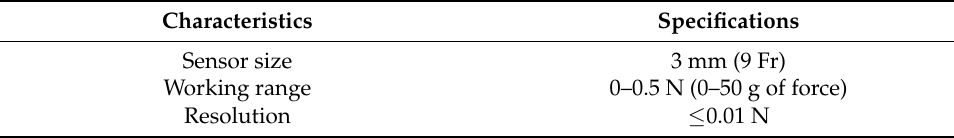
Table 1. Design specification of the proposed sensor